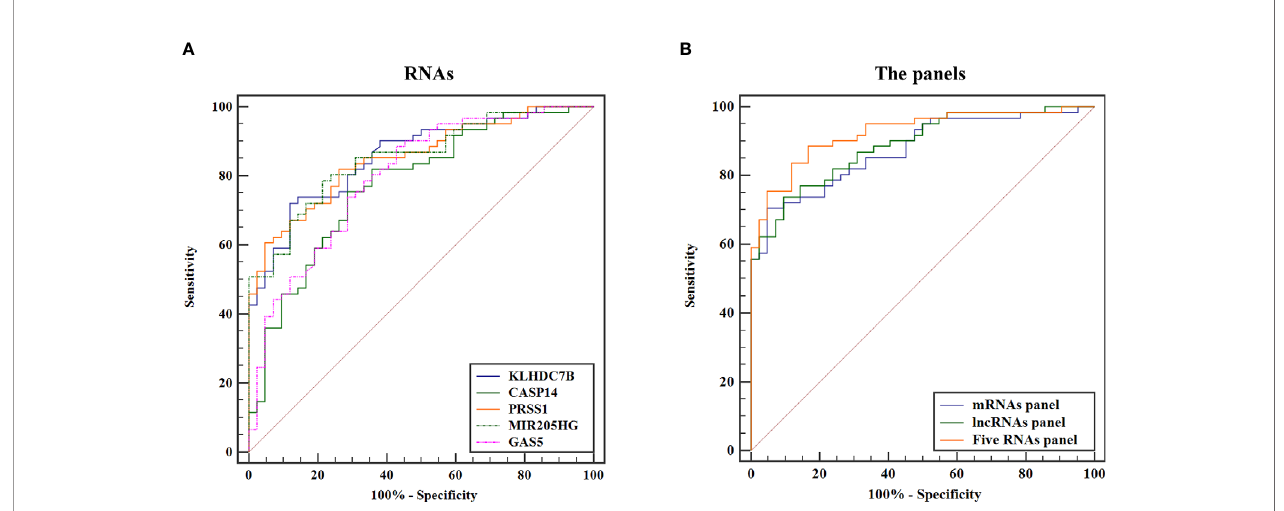
FIGURE 6 | ROC curves for discriminating BCa patients from HCs based on urine exosomal KLHDC7B, CASP14, PRSS1, MIR205HG, and GAS5 (A) alone and in combination (B) . TABLE 2 | The performance of ROC curve analysis, PPV, NPV, and accuracy for each RNAs and the combined RNAs panel in validation cohort. RNAs AUC 95% CI P value